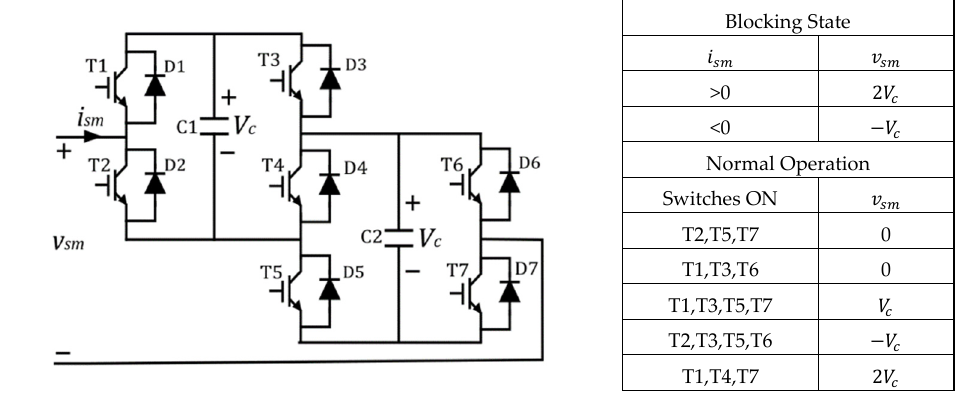
Figure 12. SFBSM.